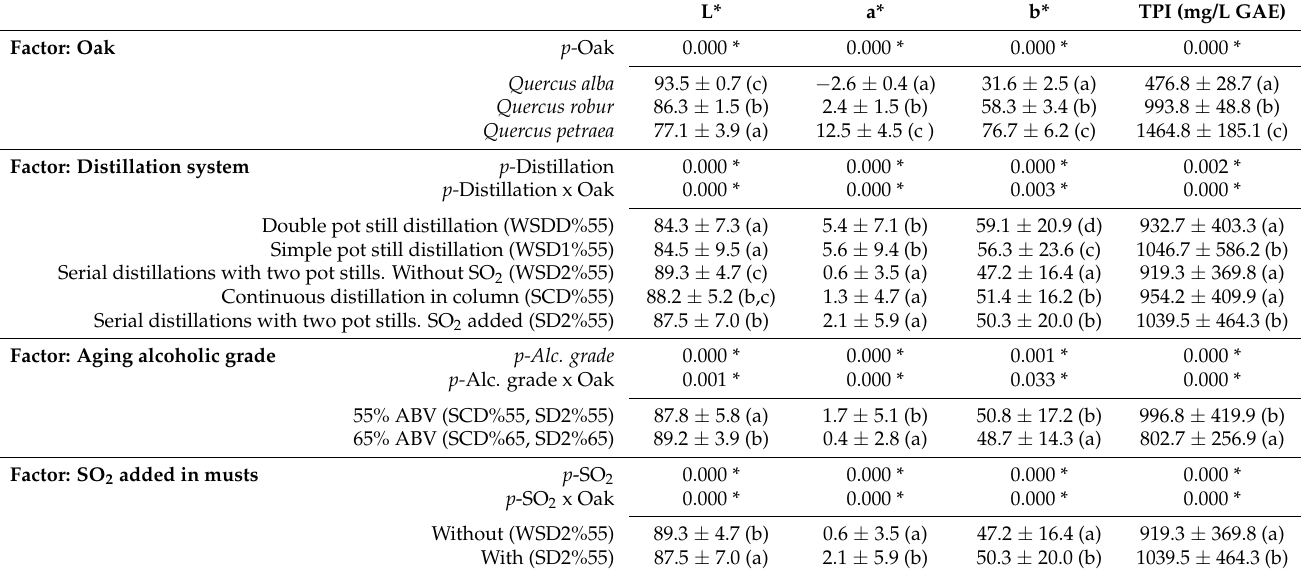
Table 5. Results from the analysis of variance applied to the data on color and total polyphenol content (TPI) of the brandies. A different letter indicates a significant level difference of the factor for p < 0.05 (*). The values are expressed as the mean ± standard deviation. L* a*